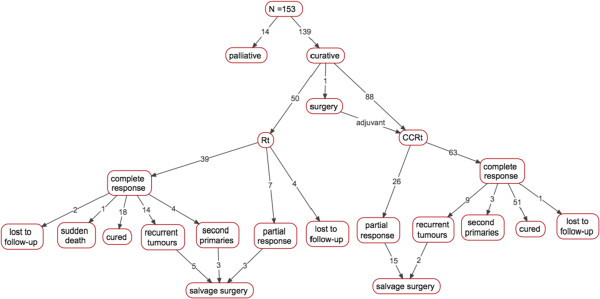
Path model for cohort of OPC patients detailing prognosis at first visit (branch 1), first-line treatment (branch 2), response to treatment (branch 3), and salvage rate (branch 4) (n = 153).